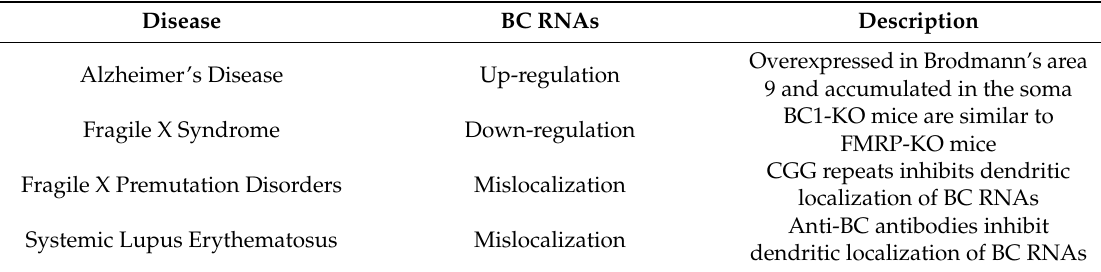
Table 1. Neuronal diseases associated with BC